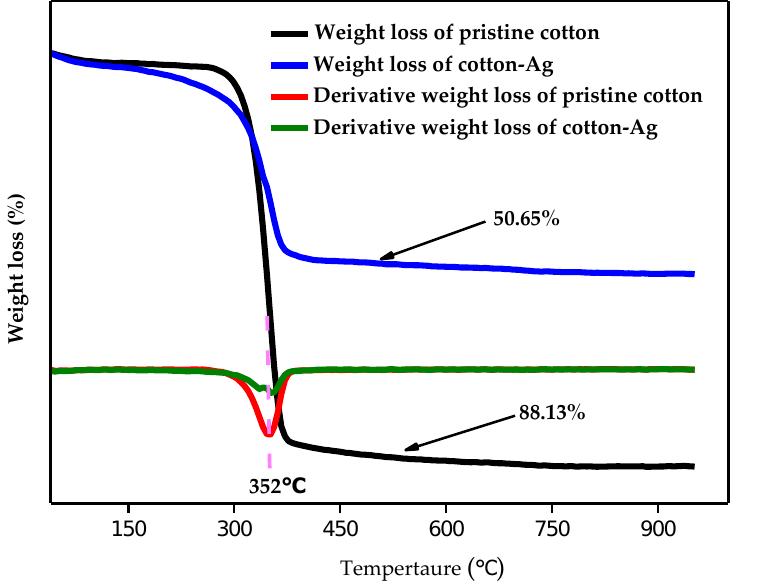
Figure 6. TGA analyses of the pristine cotton and Cotton-Ag.